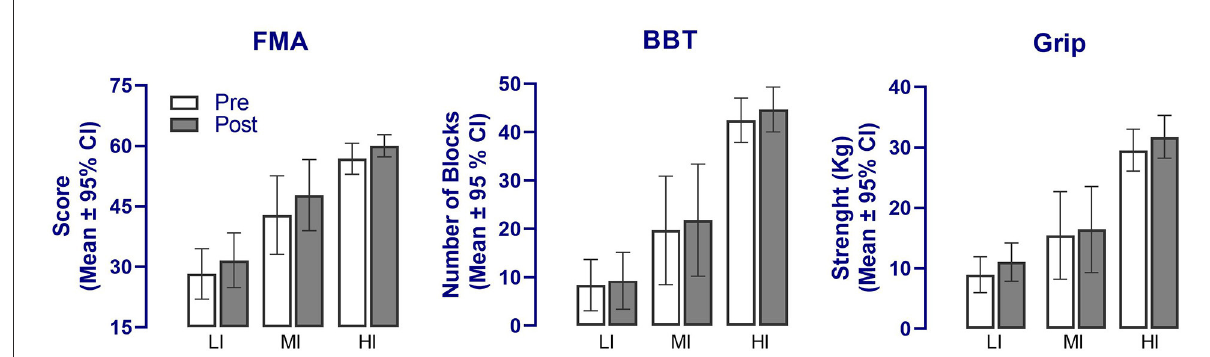
FIGURE3 Changes in the main outcome measures following the upper limb tailored strength training and anodal tDCS intervention in the three training groups. A significant effect of “Time” was detected in all three primary outcomes ( p < 0.01) but no interaction with groups. FMA, Fugl-Meyer Assessment; BBT, Box and Block test; LI, Low-intensity training group; MI, Moderate-intensity training group; HI, High-intensity training group.